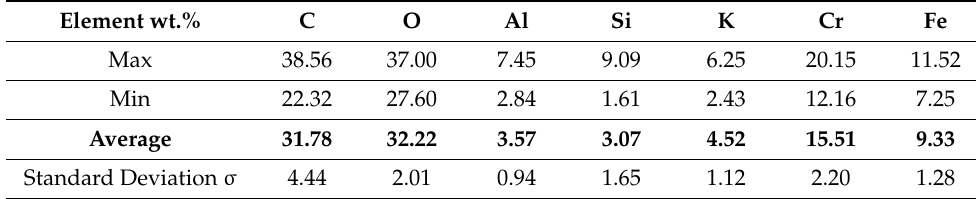
Table 3. Elemental wt.% contents of spent sand SS in the analysed area (in Figure 5b). Element